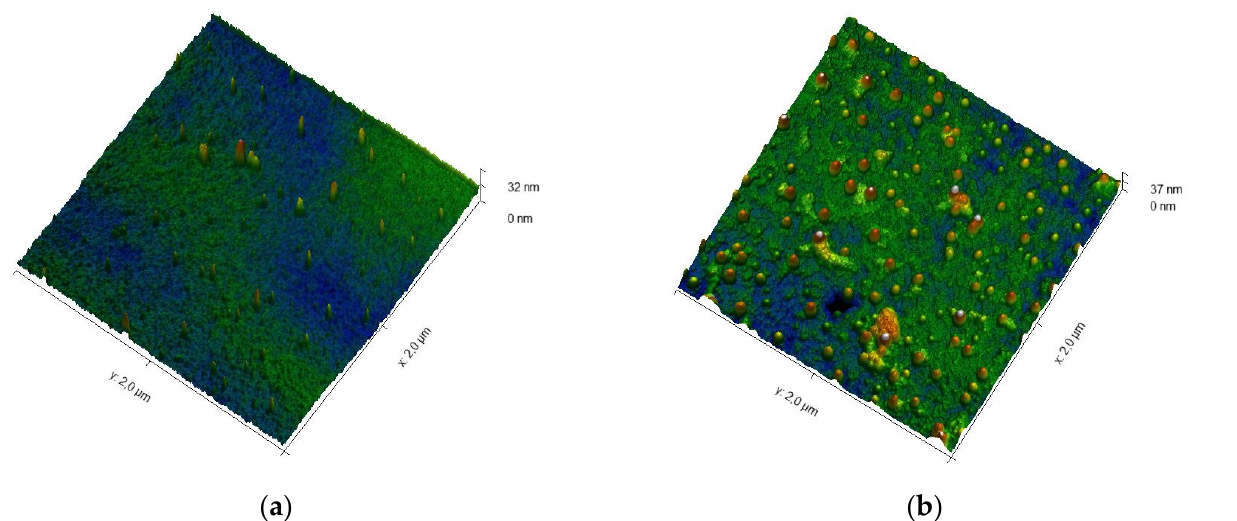
Figure 6. AFM of the surface area of BFO/Polyimide samples: ( a ) sample 1, surface morphology is not pronounced; ( b ) Sample 2, the crystalline phase is self-organized in the film.